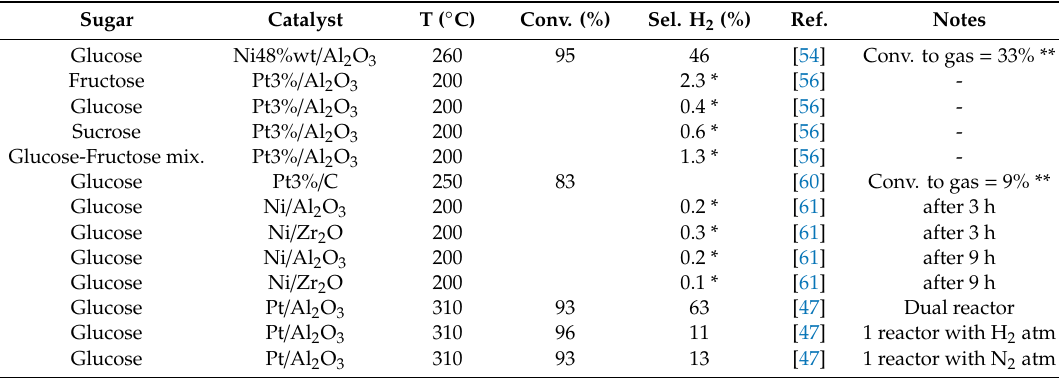
Table 2. Results of aqueous phase reforming of di ff erent